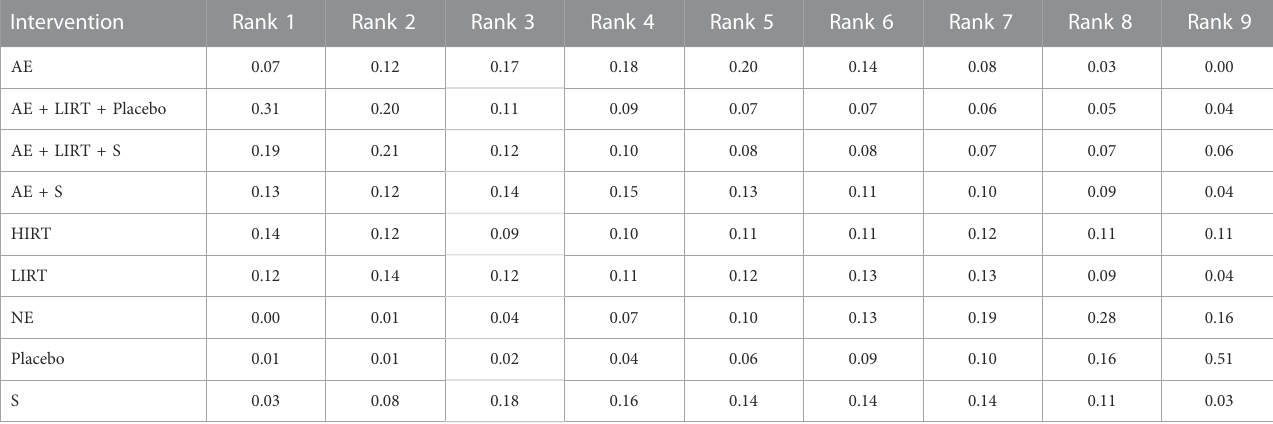
TABLE 4 Ranking of measures and probabilities a